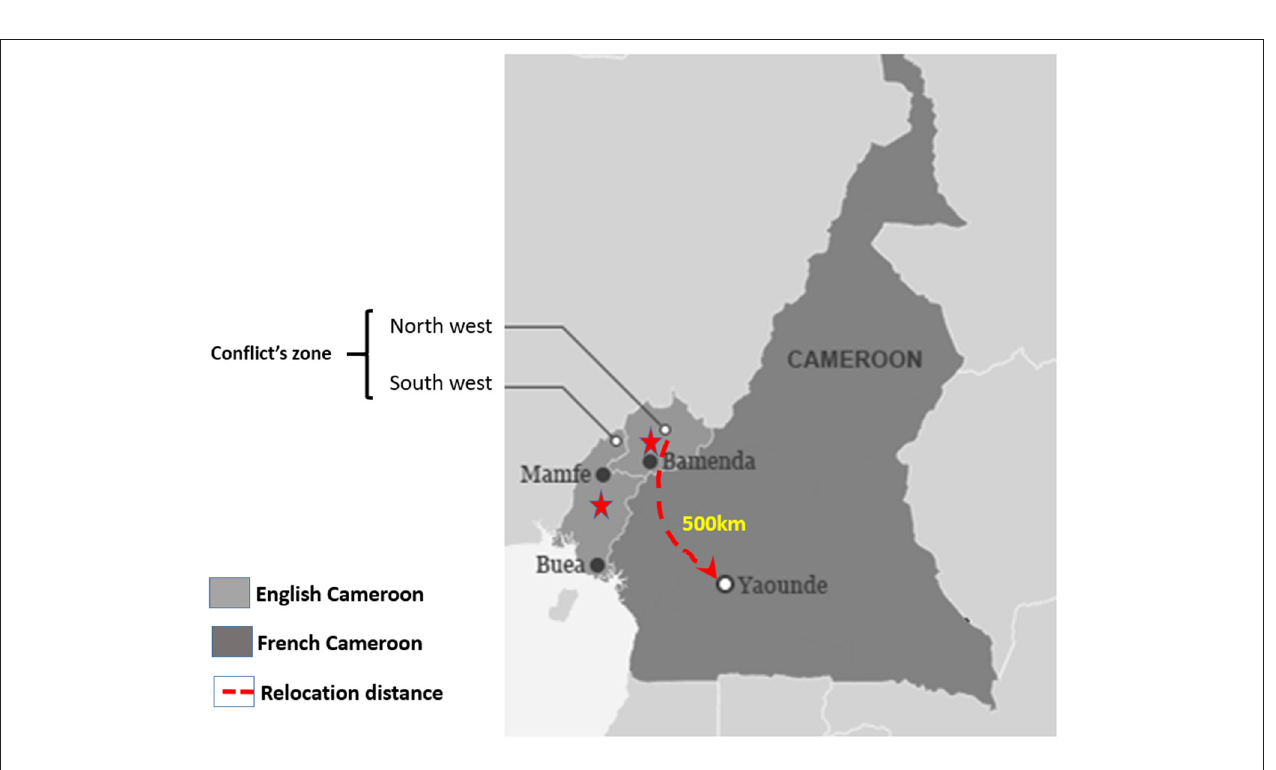
Care Unit. The movement of a catheterisation laboratory